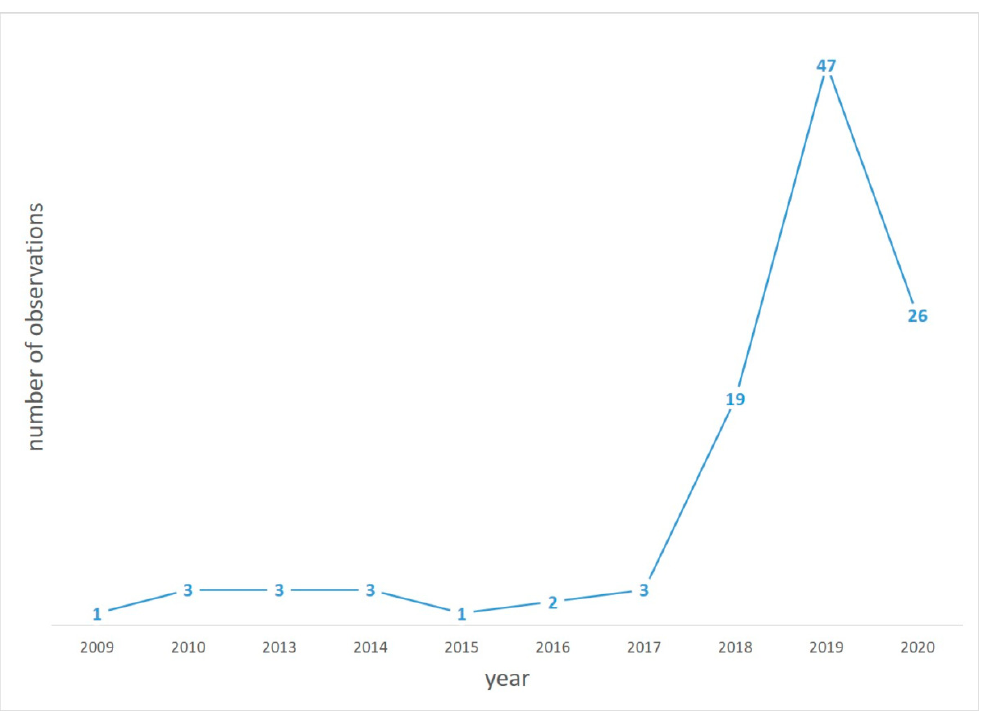
Figure 1. High abundance of Dittrichia viscosa on abandoned agriculture land in coastal Croatia.